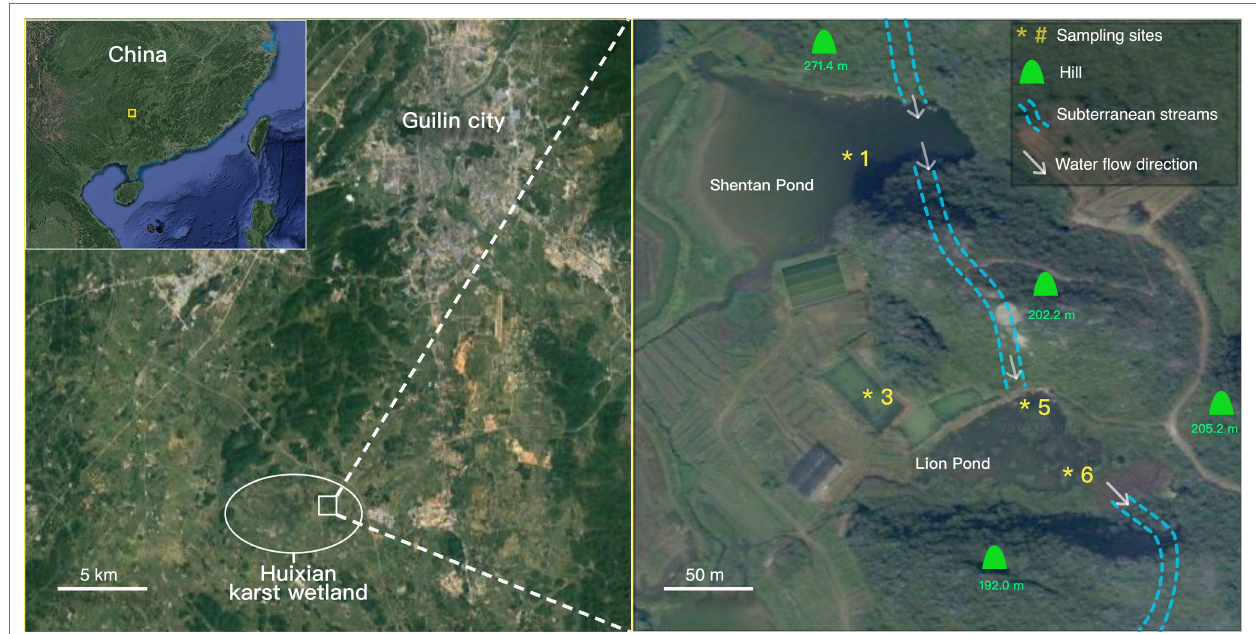
FIGURE 1 | Satellite map depicting the Huixian Research Base for Karst Geology and the sampling sites based on Google satellite